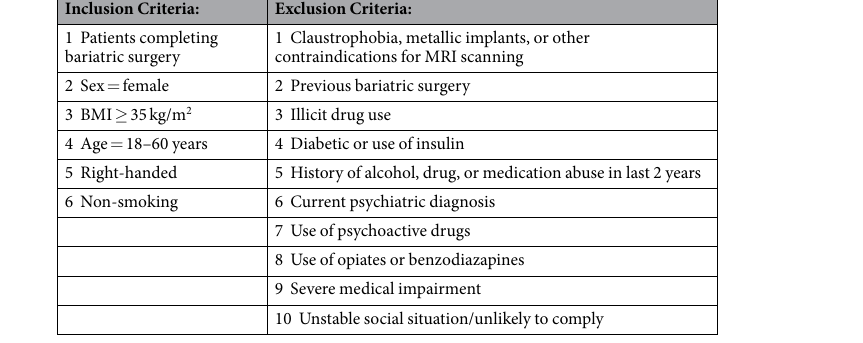
Table 5. Inclusion and exclusion criteria from the